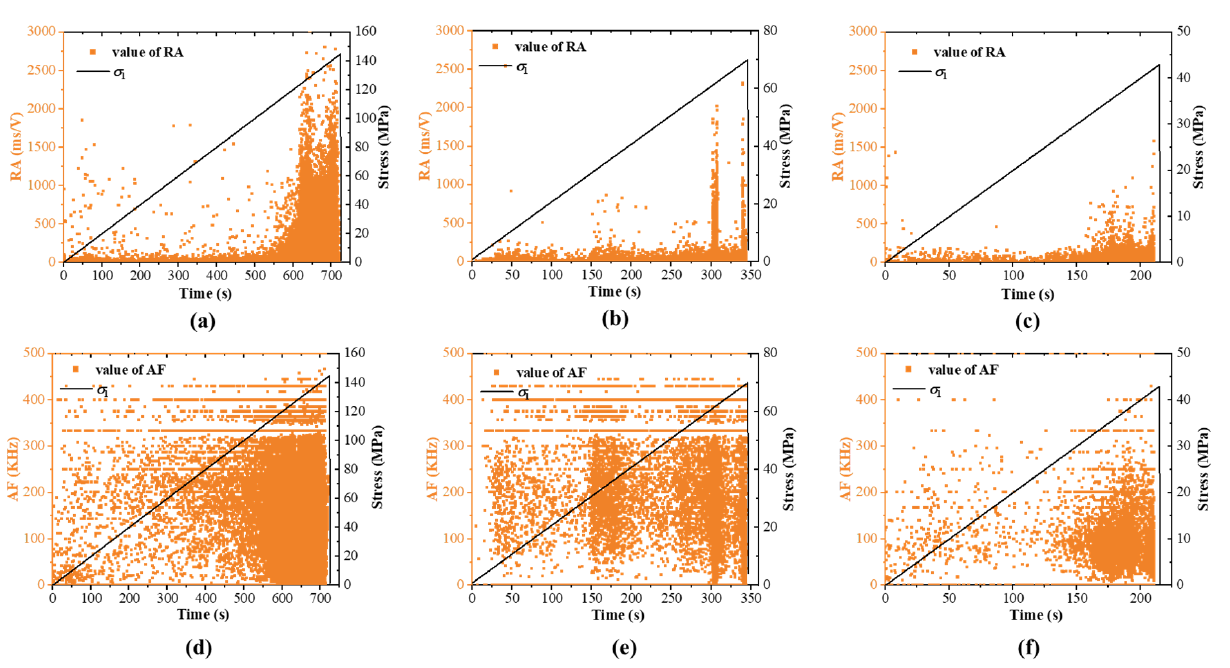
Figure 11. Time history of ( a – c ) RA, ( d – f ) AF. ( a , d ) for granite with σ 2 = 20 MPa, ( b , e ) for marble with σ 2 = 20 MPa, ( c , f ) for sandstone with σ 2 = 10 MPa.